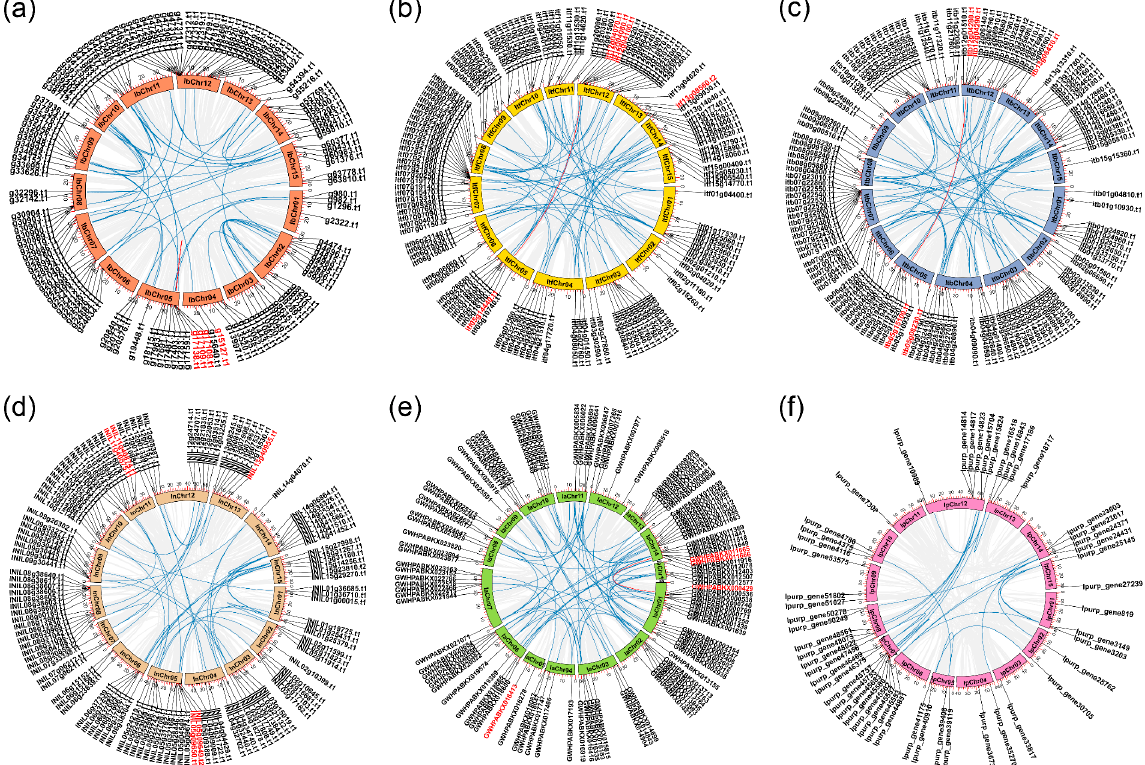
Figure 3. Chromosomal distribution and intraspecies synteny analysis of R2R3-MYBs in six Ipomoea species. ( a ) I. batatas ; ( b ) I. trifida ; ( c ) I. triloba ; ( d ) I. nil ; ( e ) I. aquatica ; ( f ) I. purpurea . The circle represents 15 chromosomes of each Ipomoea species. The R2R3-MYBs are unevenly distributed on corresponding all chromosomes in six Ipomoea species’ genomes. The blue lines show syntenic gene pairs of R2R3-MYBs , and the red lines show syntenic gene pairs of R2R3-MYBs belonging to clade C24(S6). The detailed information is listed in Table S4.